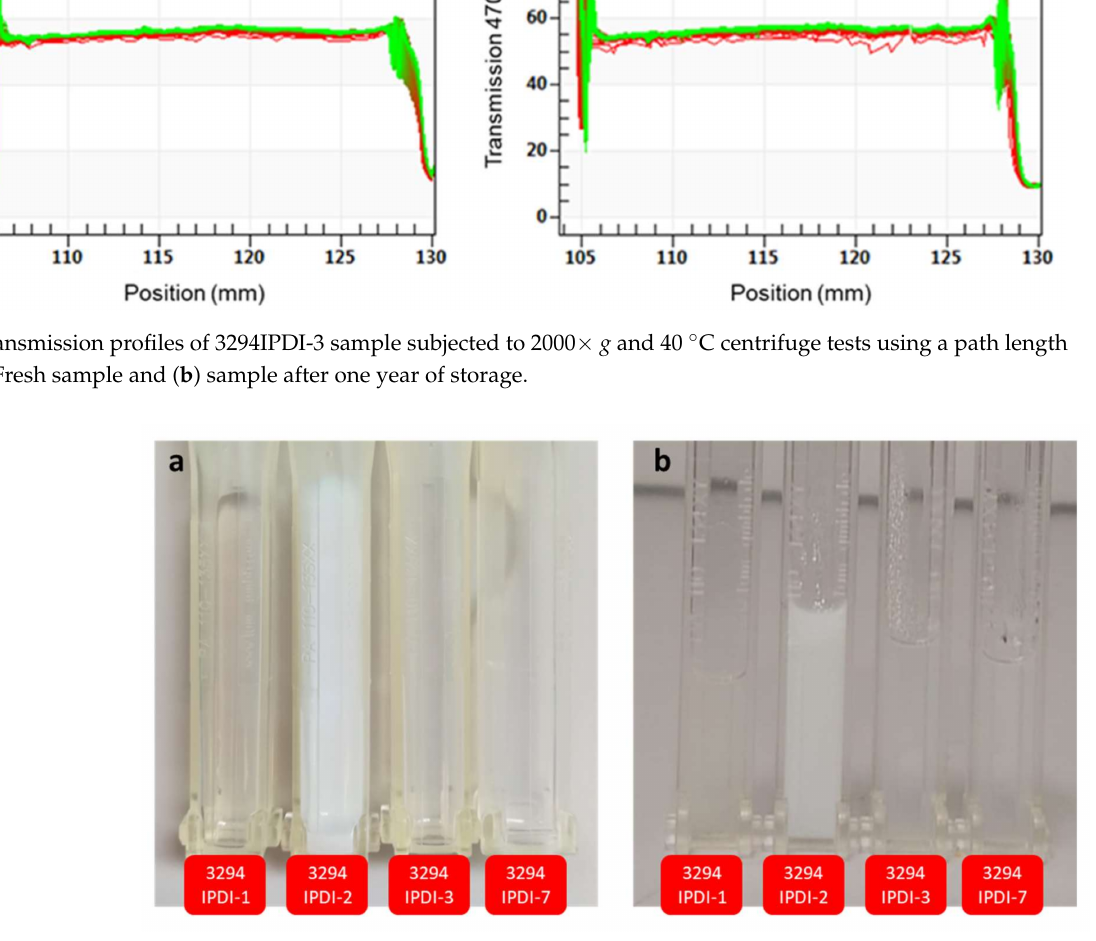
Figure 18. Photographs after centrifugation at 2000 × g and 40 ◦ C for: ( a ) fresh samples and ( b ) samples after one year of